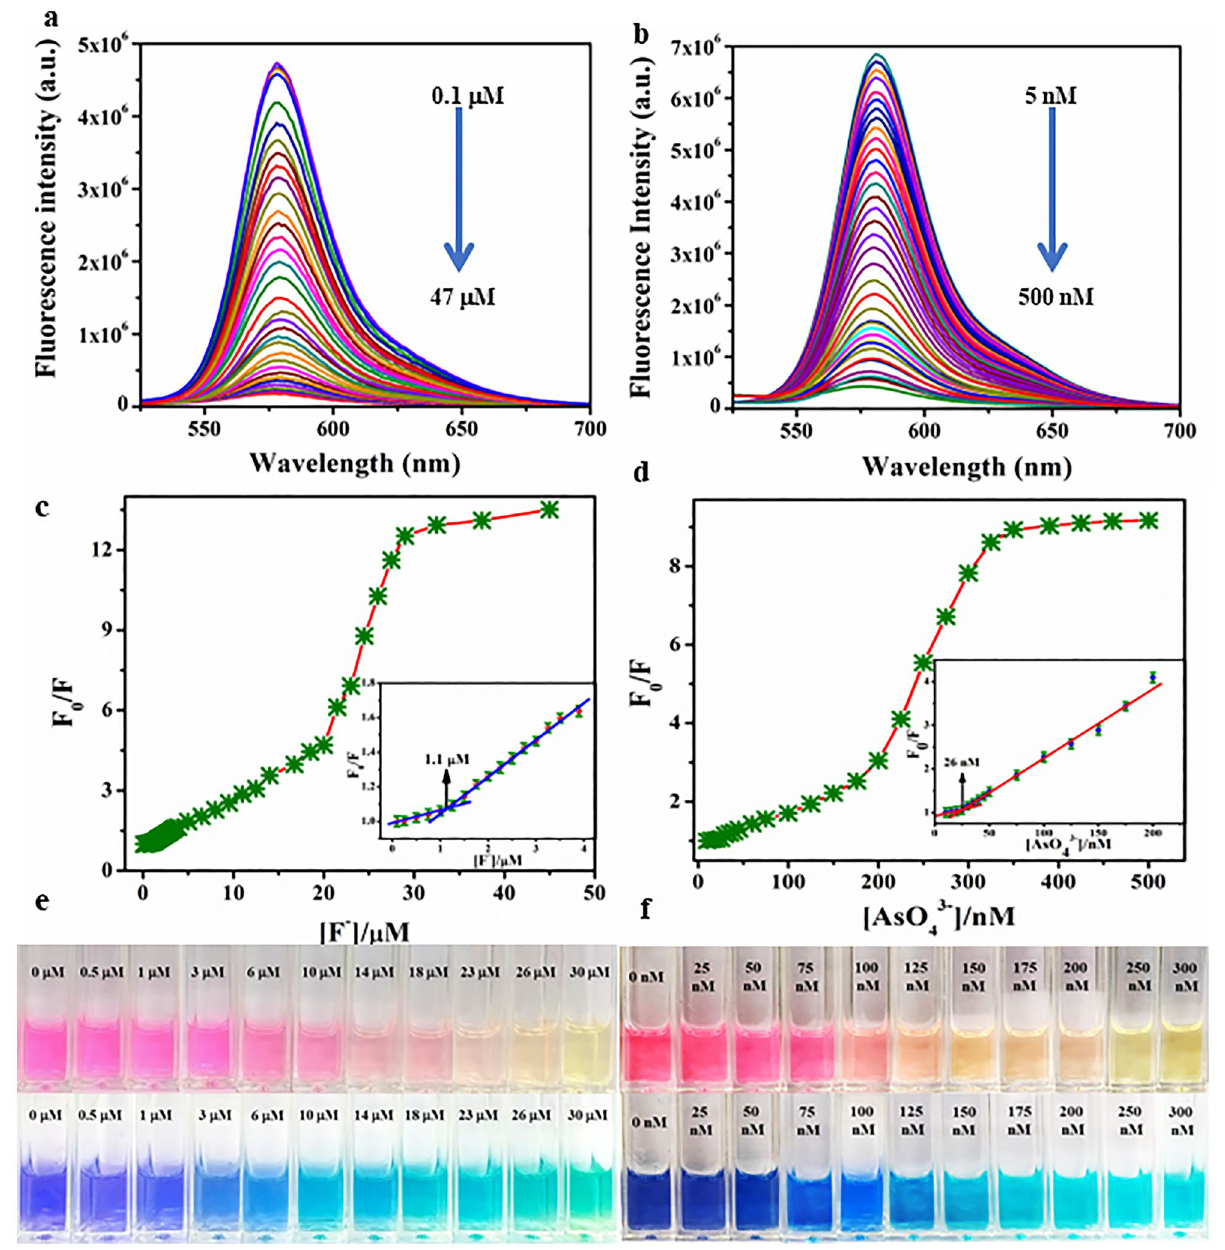
Figure 6. Fluorescence titration ( a ) Change in emission intensity of C 1 with the addition of an increasing amount of fluoride (0.1–47 μM), ( b ) Change in emission intensity of C 2 with the addition of an increasing amount of arsenate (5–500 nM), ( c ) Stern–Volmer plot for fluoride, Inset: LOD, ( d ) Stern–Volmer plot for arsenate, Inset: LOD; Change in color of C 1 ( e ) and C 2 ( f ) upon incremental addition of fluoride and arsenate respectively (top), the addition of an equal proportion of methylene blue dye onto each solution